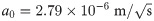
The amount of ciprofloxacin WB which diffuses into part B.Points represent the experimental data (see S1 File) and lines represent theoretical functions. Line No. 1 (dashed line) corresponds to function W0B
Eq (8) for a0=2.79×10-6m/s and b0 = 4.21 × 10−5 m/s0.04, line No. 2 (solid line) represents Wκ˜(t)B
Eq (10) for aκ = 1.59 × 10−4 m, bκ=3.53×10-4ms and cκ = 2.22 × 10−2 m s0.96, a = 1.28, and b = 1850 s, line No. 3 (dashed–dotted line) represents WκB
Eq (9), t1 = 3900 s, t1 = 6800 s, C0 = 3.02 mol/m3, and Π = 7.0 × 10−5 m2. For all cases α = 0.96. The two vertical dotted lines are the boundaries between the stages.